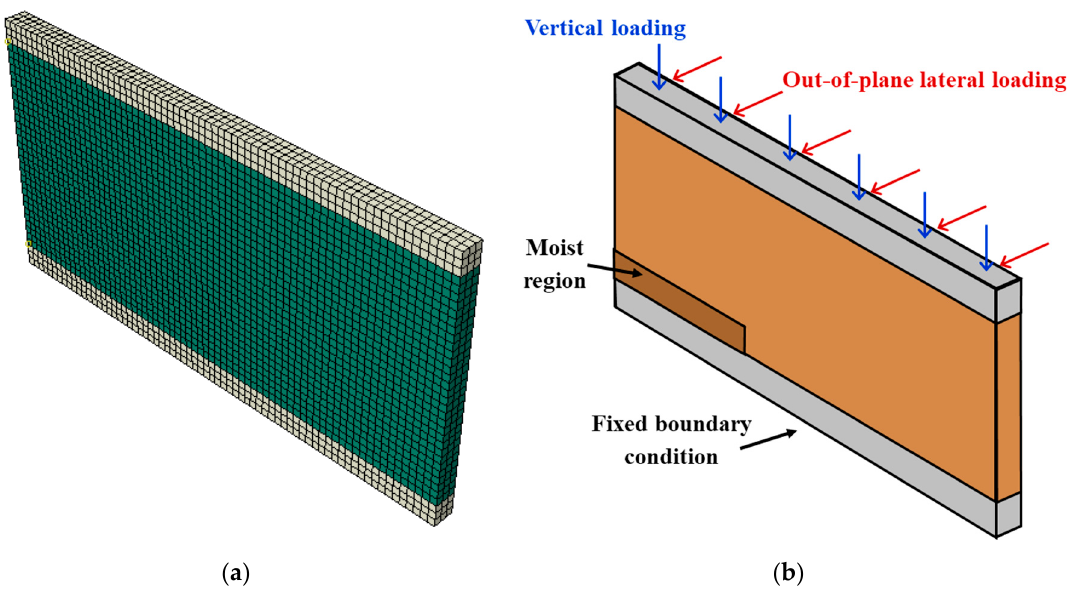
Figure 1. Finite element model of the adobe wall: ( a ) wall geometry and mesh ( b ) loading and boundary conditions.